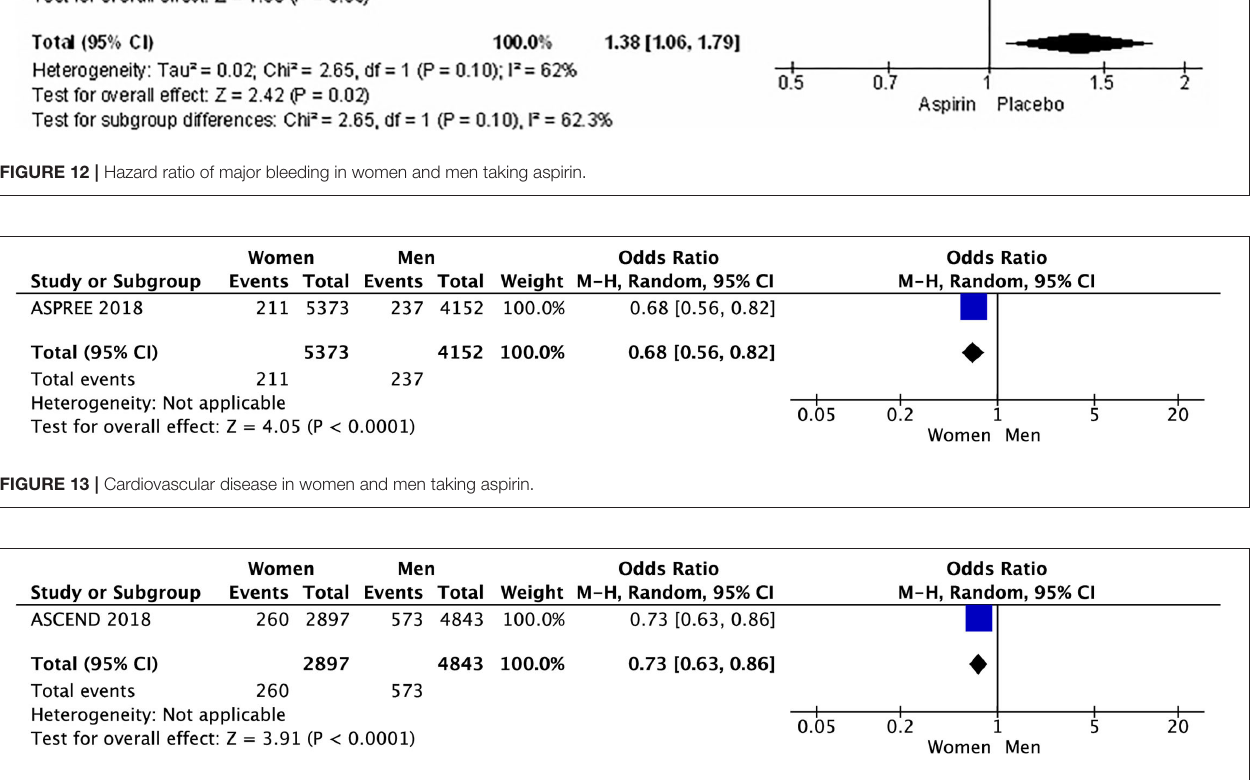
FIGURE 14 | Vascular event/Revascularization in women and men taking